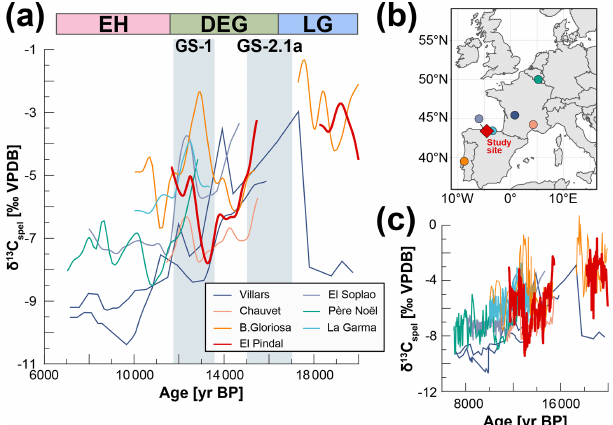
Figure 1. Speleothem δ 13 C records covering the last deglaciation in temperate western Europe. (a) δ 13 C spel vs. age, colour-coded by cave. Villars Cave – stalagmites Vil-stm11 (Genty et al., 2006) and Vil-car-1 (Wainer et al., 2011); Chauvet Cave – stalagmite Chau- stm6 (Genty et al., 2006); El Pindal Cave (studied here)– previously published record from stalagmite Candela (Moreno et al., 2010); La Garma Cave – stalagmite GAR-01 (Baldini et al., 2015); El Soplao Cave – stalagmite SIR-1 (Rossi et al., 2018); Père Noël Cave – sta- lagmite PN-95-5 (Verheyden et al., 2014); Buraca Gloriosa – sta- lagmite BG6LR (Denniston et al., 2018). All stalagmite data were extracted from the SISAL database, version 2 (Comas-Bru et al., 2020b, a). Shown here is the millennial-scale trend in the records, calculated using a Gaussian kernel smoother (nest package in R, Rehfeld and Kurths, 2014). Please note that the record from Vil- lars Cave is very low resolution but no hiatus is reported between 18–14ka. Time slices at the top of the figure are as defined for the modelling in this study. GS: Greenland Stadial, as defined in Ras- mussen et al. (2014). (b) Cave locations. (c) Original (not filtered)